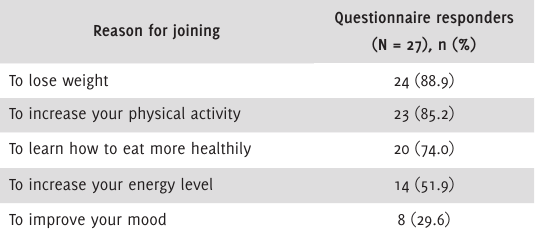
Table 2. Reasons for Joining Hockey FIT as Given by the Intervention